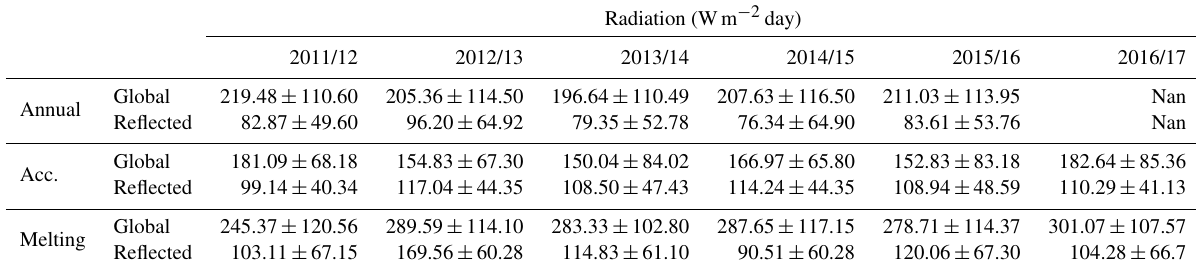
Table 6. Mean global and reflected radiation for the five snow seasons for the annual, accumulation and melt periods.